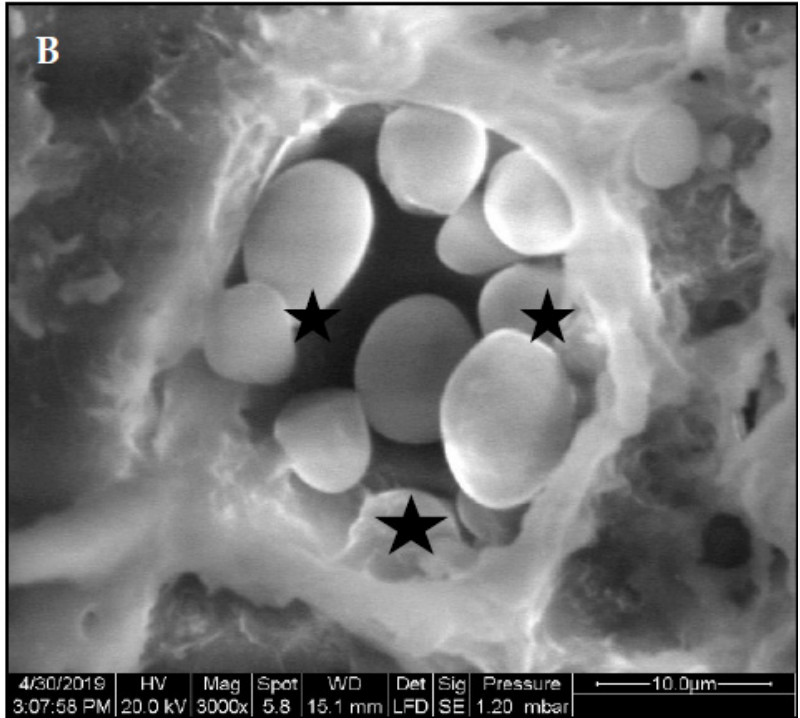
Figure 5. Stem cross section of Razegui1 cultivar imaged in ESEM analysis: ( A ): inserted tyloses in the cell wall of the vessel lumen (white arrow) and in the parenchyma zone (white arrows). ( B ): tyloses visualized at different stage of development inserted in the pit membrane and obstructing the vessel lumen (black asterisks).